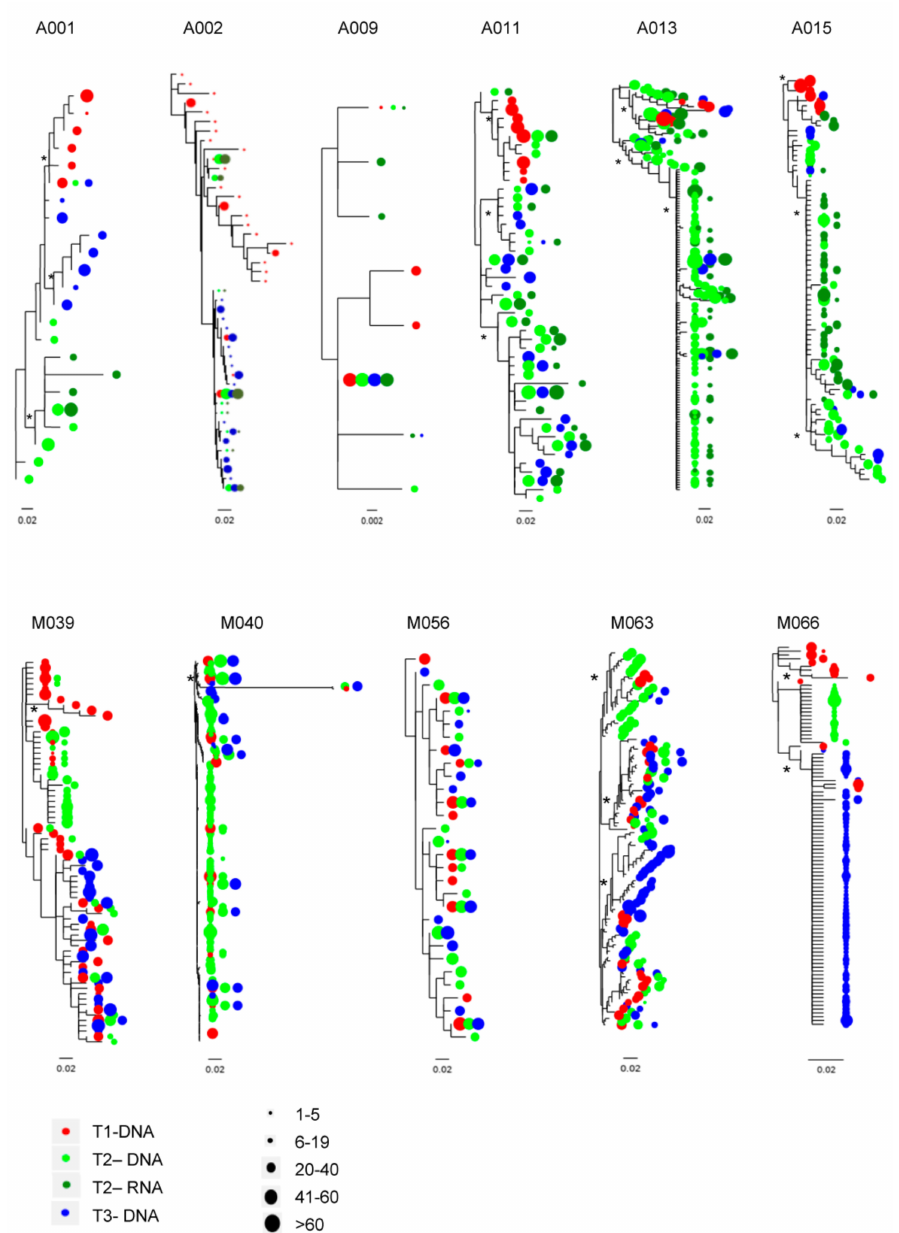
Figure 3. Maximum likelihood phylogenetic reconstruction of C2-V3-C3 region in APACHE (A) and MODAt (M) patients (PhyML). C2-V3-C3 sequences were used to construct maximum likelihood phylogenies. Time points 1, 2, and 3 are depicted in red, blue, and green, respectively. RNA at time 2 is depicted in dark green. Tip size is proportional to variant frequency. Scale bars are in substitutions/site. Asterisks (*) indicate a bootstrap ≥